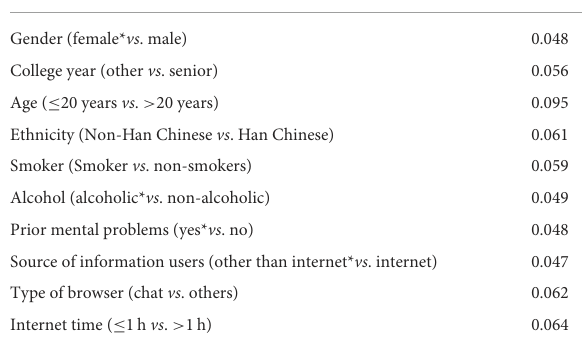
TABLE 6 Association of